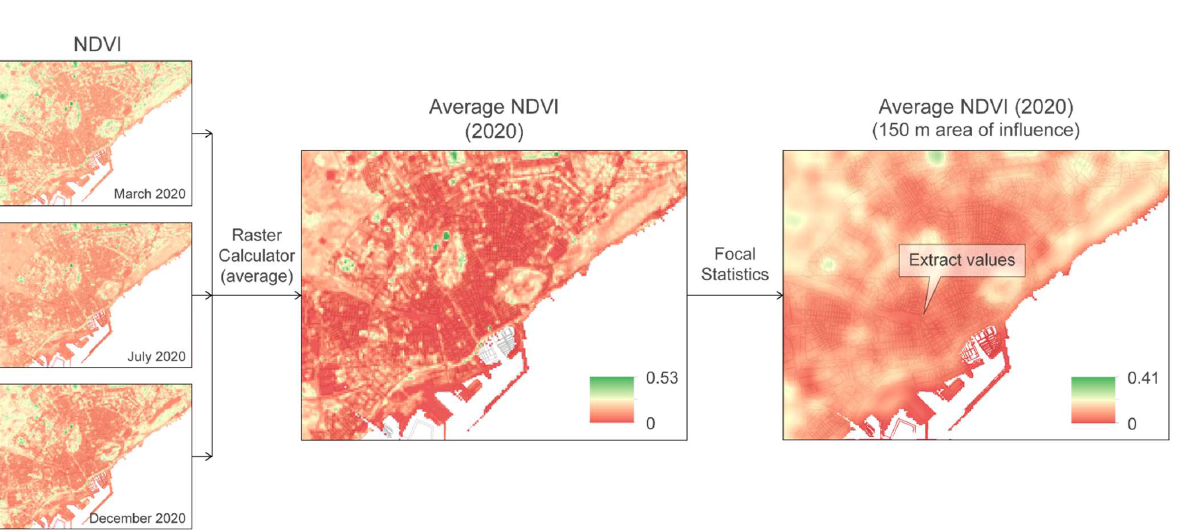
( b ) Figure 4. Maps of the city of Alicante. ( a ) Urban street network and level 1 educational centers (infant and primary); ( b ) map of distances (service areas) to level 1 educational centers (infant and